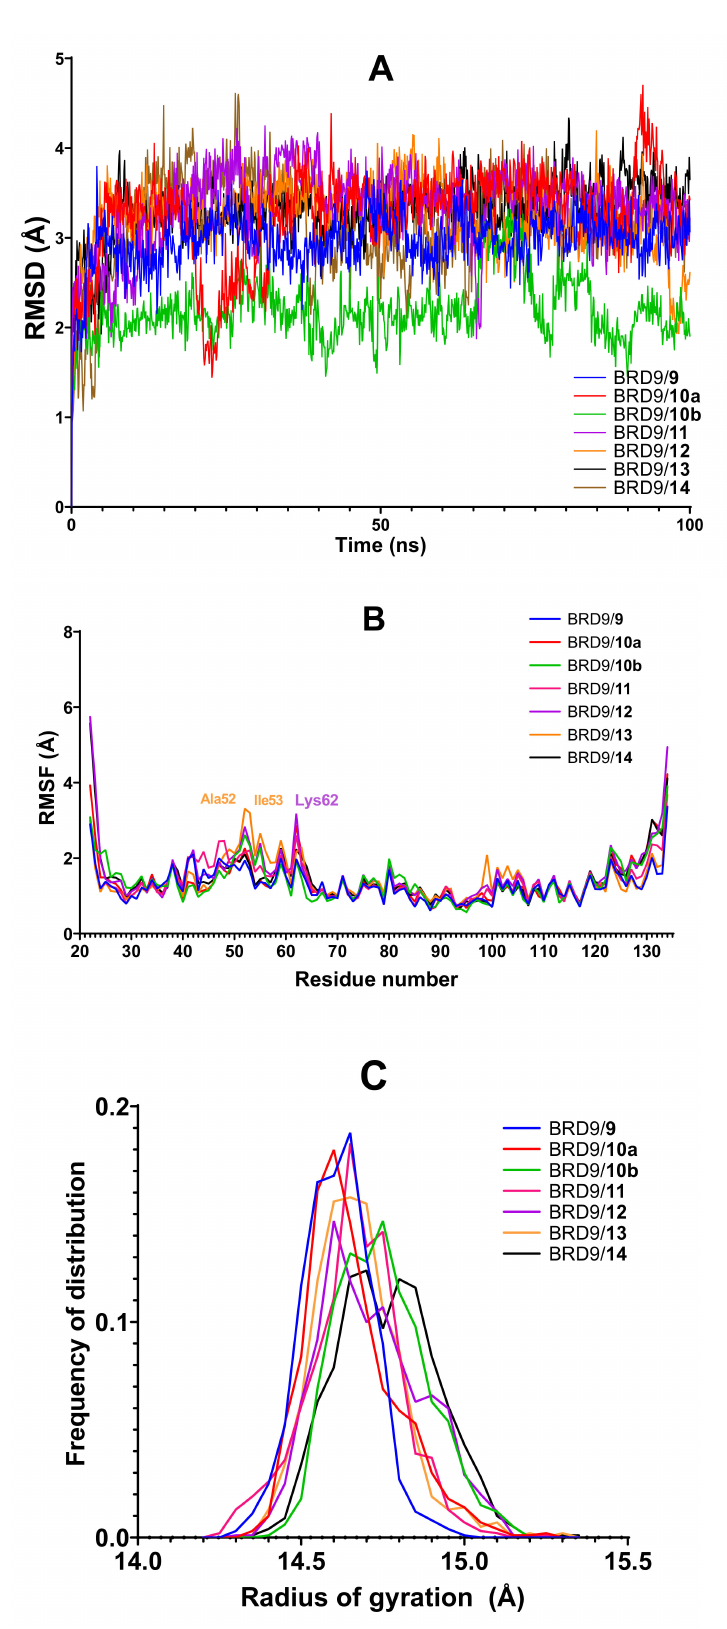
Figure 12. ( A ) RMSD, ( B ) RMSF, and ( C ) Rg analysis of the six protein-ligand complexes. The analysis of the per-residue interactions (Figure 13) provided, as expected, a useful insight into the behavior of each molecule. Specifically, compound 9 received the